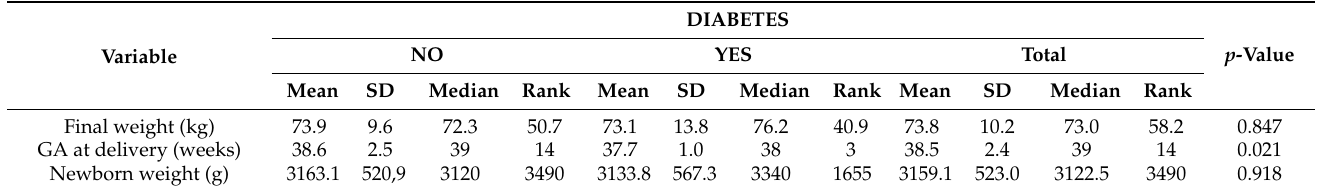
Table 2. Perinatal results of pregnant women with GDM and those with